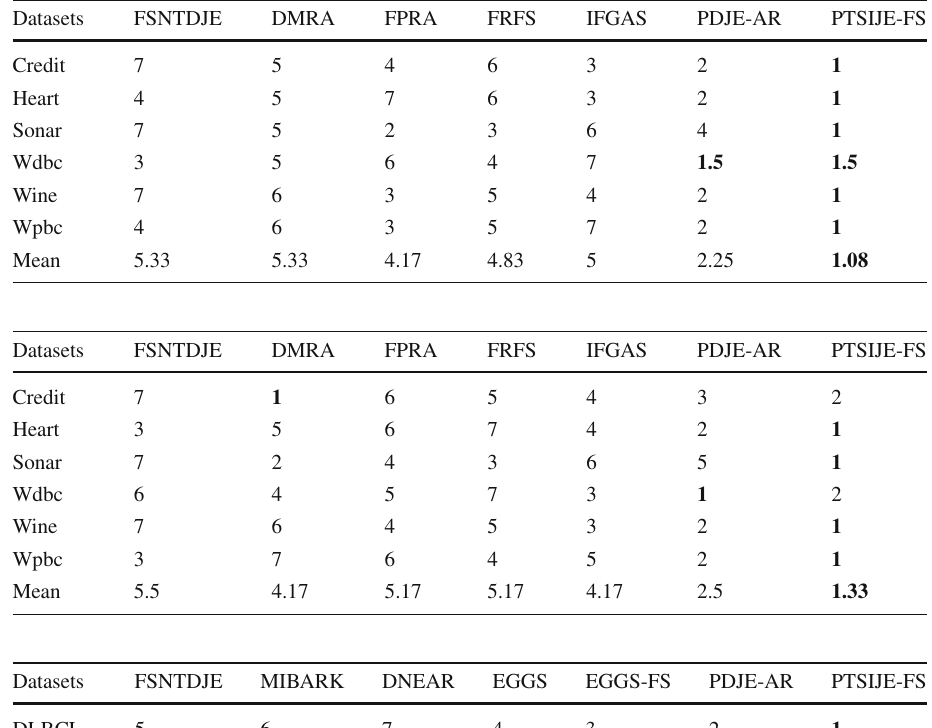
Table 13 Rank of the seven methods with KNN